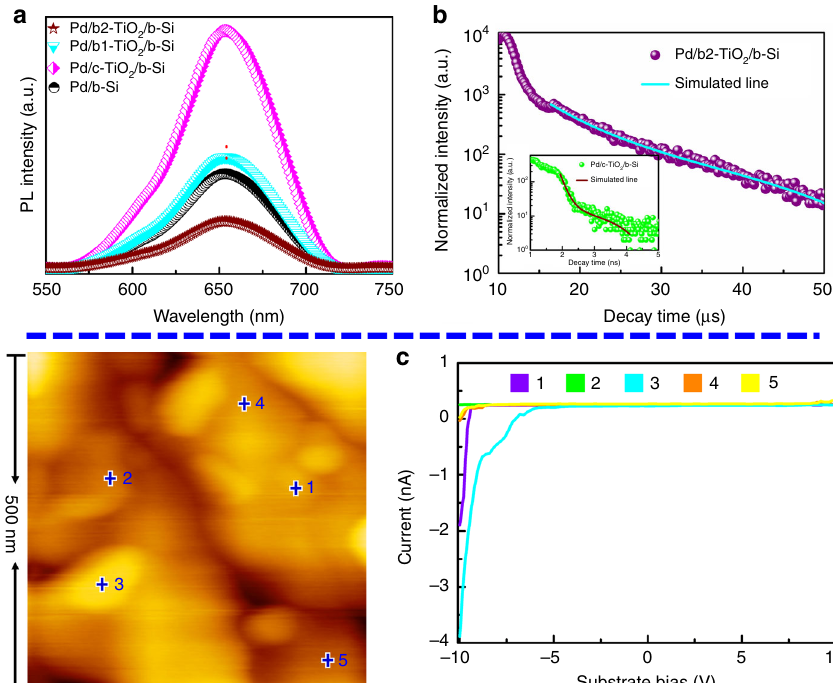
Fig. 6 Charge carrier dynamics and paths of the samples. a Room temperature PL spectra of Pd/b-Si (black), Pd/c-TiO 2 /b-Si (pink), Pd/b1-TiO 2 /b-Si (Cambridge blue) and Pd/b2-TiO 2 /b-Si (brown) with excitation wavelength of 405 nm. b Time-resolved PL decay curve for Pd/b2-TiO 2 /b-Si at room temperature. Solid lines represent the kinetic fi t using bi-exponential decay model. The inset is the time-resolved PL decay curve dor Pd/c-TiO 2 /b-Si. c AFM topography image and typical I – V curves of marked position by the number for Pd/b2-TiO 2 /b-Si. Position 1, 2, 3, 4, and 5 in AFM image corresponding to purple, green, Cambridge blue, orange and yellow I – V curve,